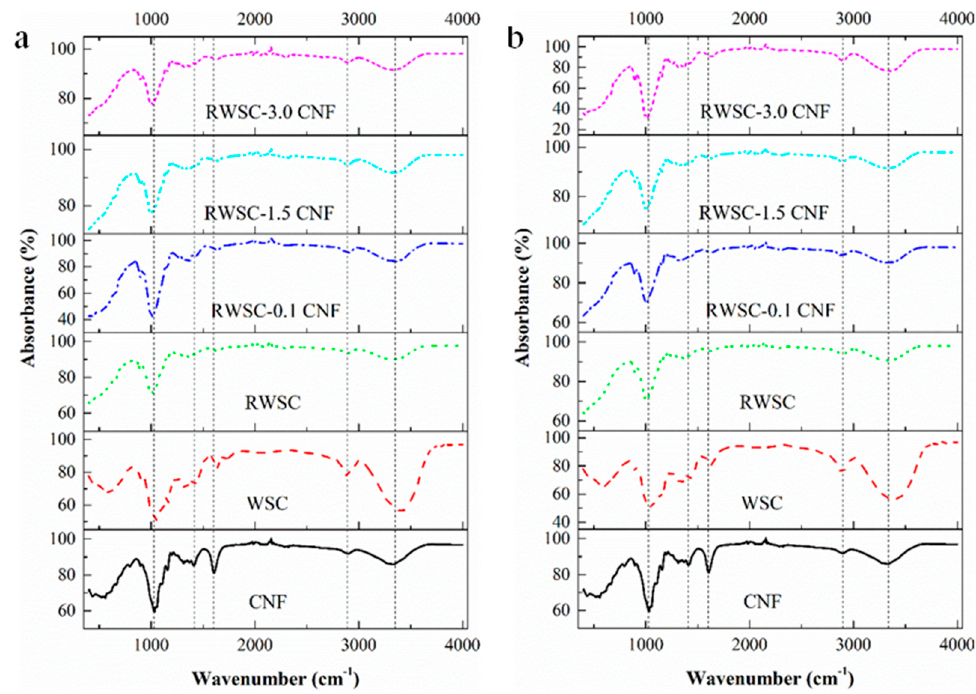
Figure 8. FTIR curves of WSC, RWSC, and all-cellulose nanocomposites: ( a ) WSC prepared by AM; ( b ) WSC prepared by EM.